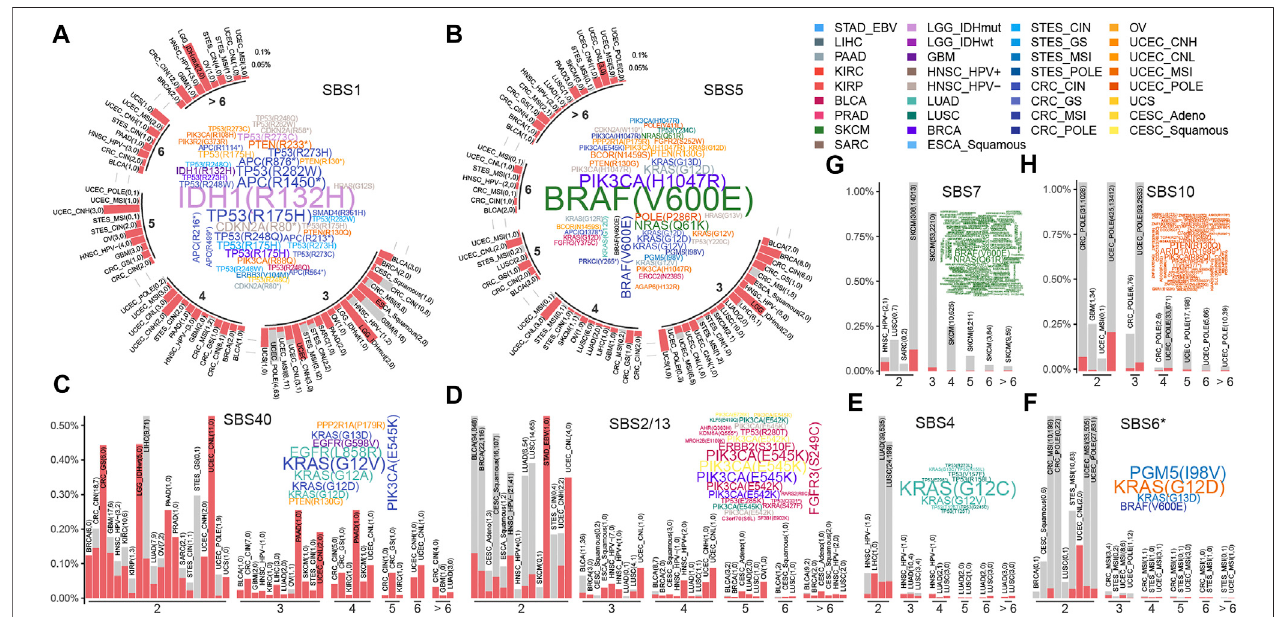
FIGURE 2 | The recurrent mutations shaped by mutational processes. Barplots and word clouds illustrate the recurrent mutation landscapes for (A) SBS1, (B) SBS5, (C) SBS40, (D) SBS2/13, (E) SBS4, (F) SBS6*, (G) SBS7, and (H) SBS10. Barplot depicts a recurrence pattern, where mutations were binned by their reoccurrence frequency and the height of the bar represented the fraction of mutations in each cancer type or subtype. The numbers of mutations in and out of cancer geneswere fi lledbyredand grayrespectivelyandalso showedinparenthesesseparatedbycommasineach cancertypeorsubtype. Thebar plotisdisplayed ina circularlayoutin (A) and (B) .Wordcloudsshowhigh-frequencymutationsoccurringatleast6timesinacancertypeorsubtype,ofwhichwordsizeisproportionaltothe number of mutations and word colored by cancer type or subtype.